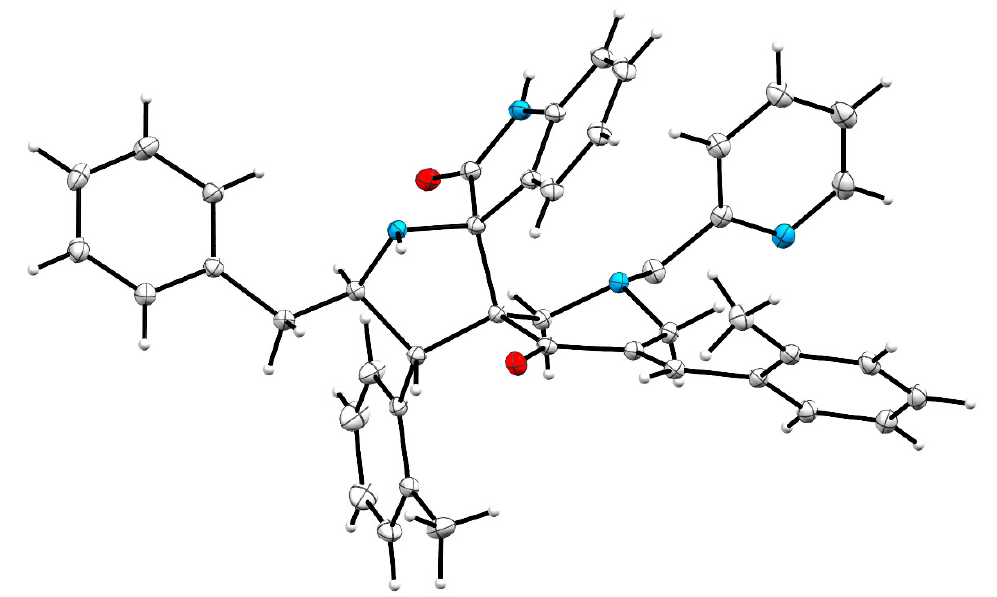
Figure 2. Oak Ridge Thermal Ellipsoid Plot (ORTEL) diagram of 8e.